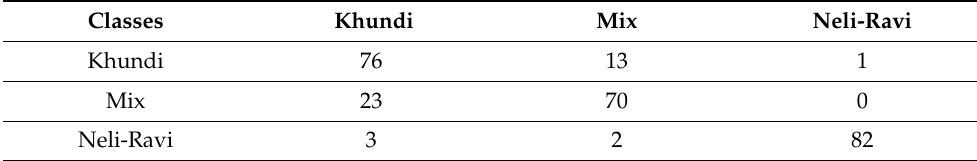
Figure 7. Prediction plot obtained using different ML classifiers on 60-40 split. Table 8. Confusion matrix obtained using SVM.